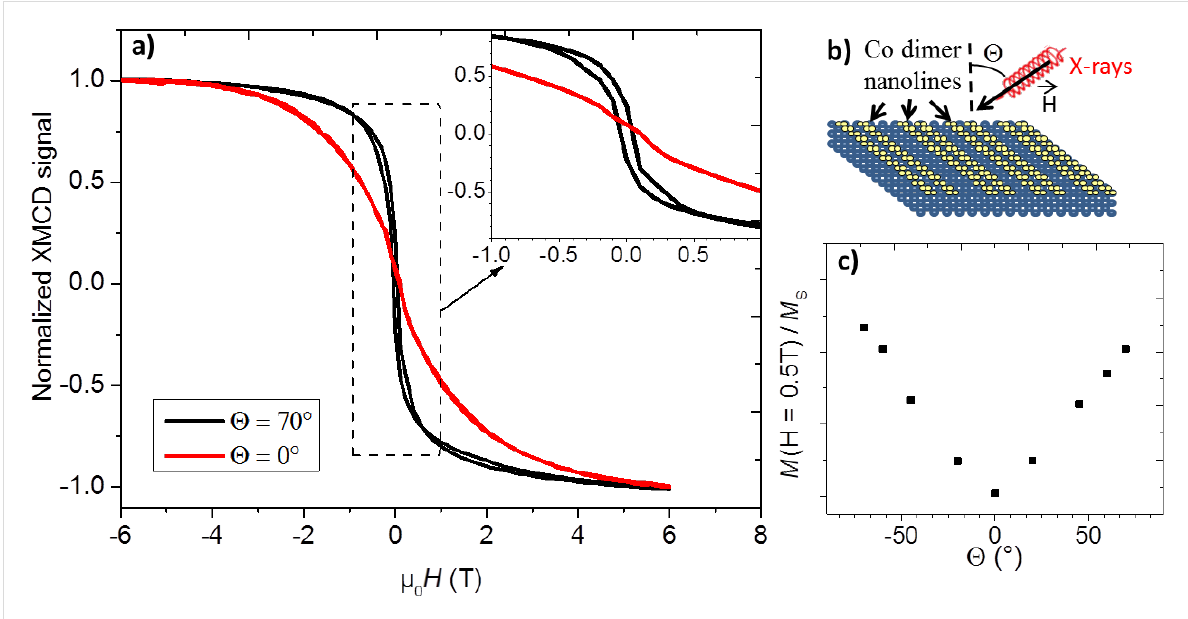
Figure 4: (a) Hysteresis loops of 2 ML Co on Si/Ag(110) measured at 4 K at normal ( Θ = 0°) and grazing ( Θ = 70°) incidences. The curves have been normalized to their saturation value. (b) Schematic representation of the measurement configuration: incident light and magnetic field are parallel and form an angle Θ with the surface normal in the plane perpendicular to the Co nanolines. (c) Variation of the magnetization at 0.5 T normalized to the saturation magnetization ( M S ) as a function of the incidence angle, Θ